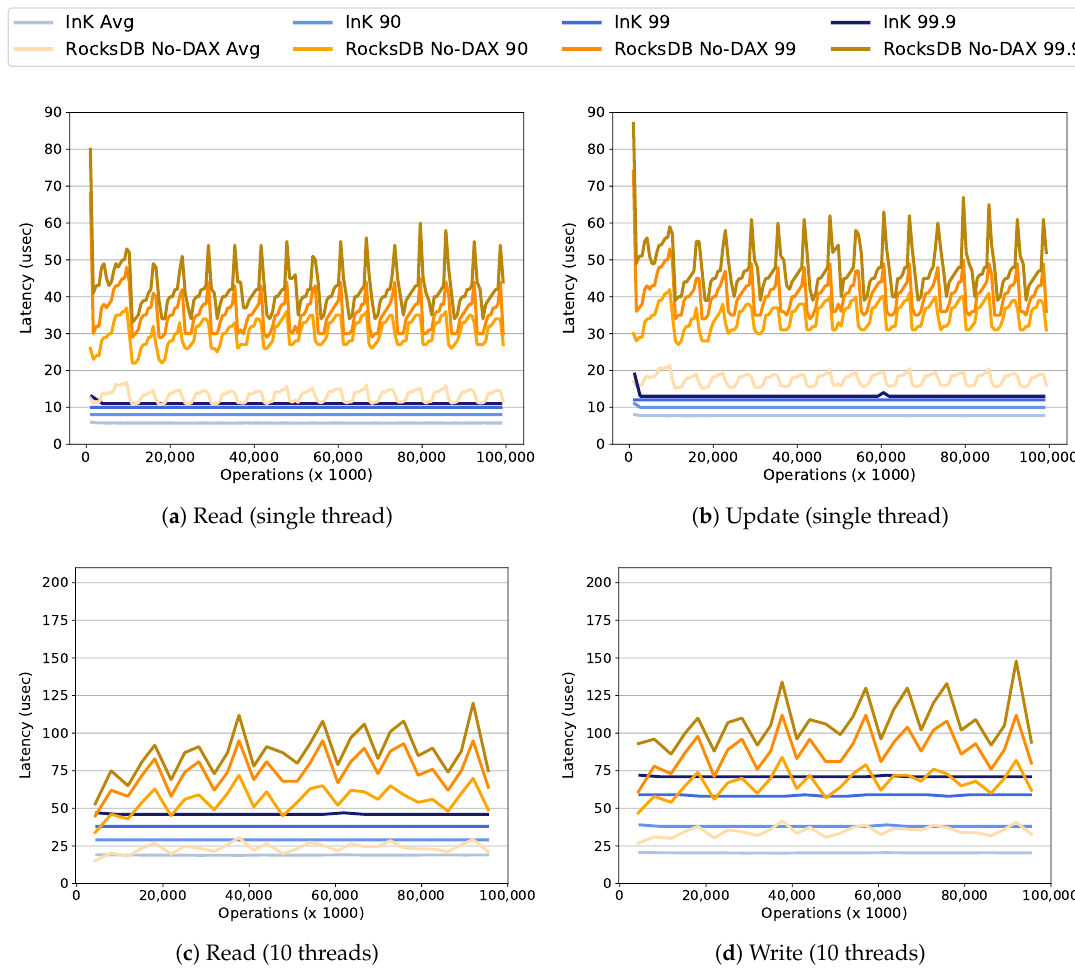
Figure 12. Tail latency for YCSB Workload A. RocksDB is configured without DAX and key selection is in the Zipfian